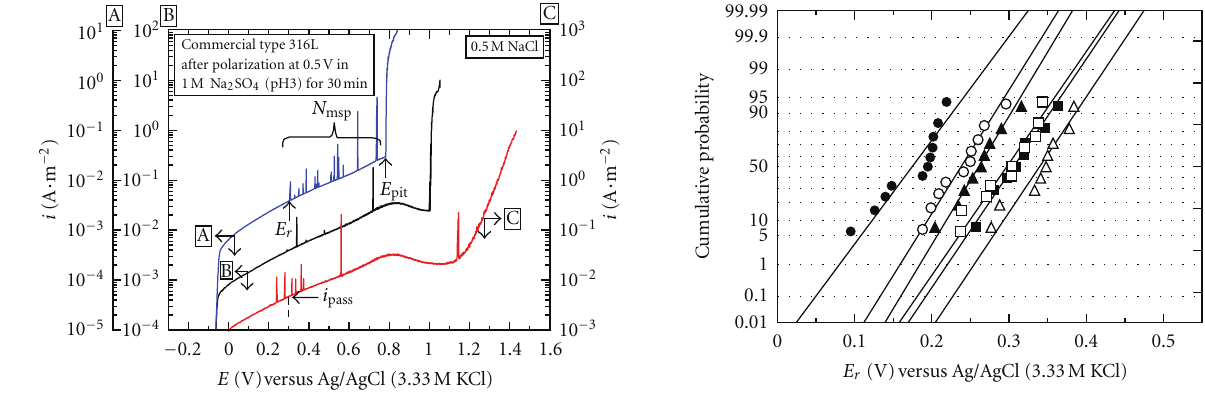
Figure 4: Anodic polarization curves of commercial Type 316L stainless steels in 0.5M NaCl after polarization treatments at 0.5 V for 30min in 1 M Na 2 SO 4 of pH 3. The value of current density in each curve with a label of A, B, or C is given by the ordinate scale with the corresponding label. Figure 5: Normal probability plots of onset potential of metastable